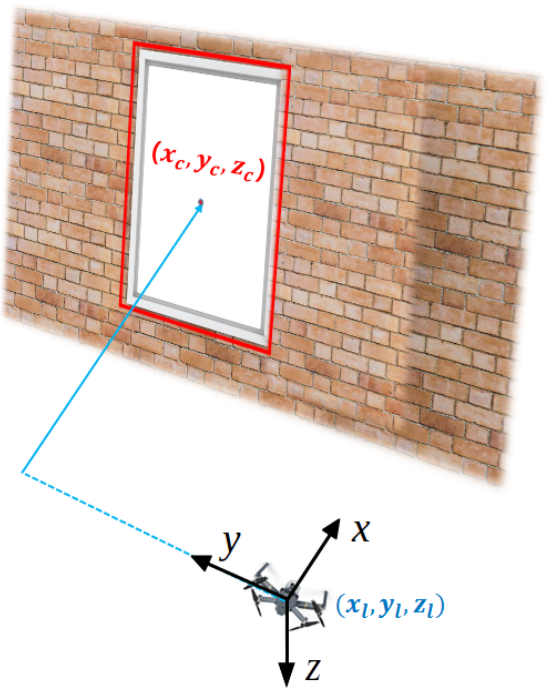
Figure 4. Open obstacle passing